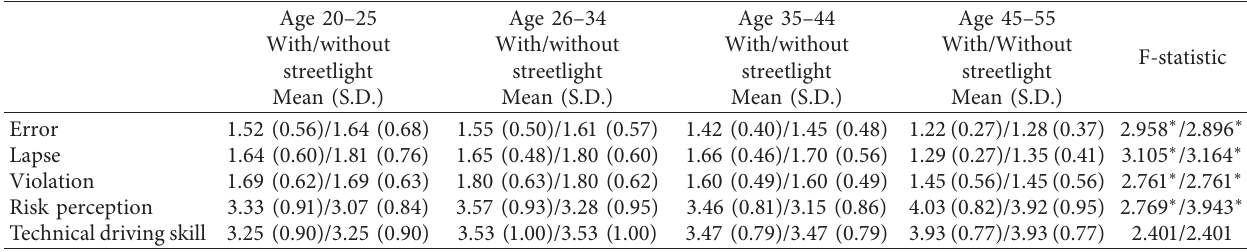
Table 9: Differences according to age for the DBQ and DSI factors.